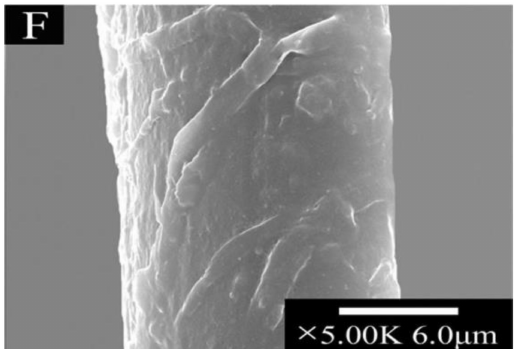
Figure 5. Hyperbranched polysiloxane (HPSI) coated aramid fiber [83]. Reprinted with permission from [83]. Copyright 2014